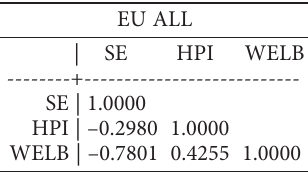
Table 3. Correlation Matrix (between SE, HPI and WELB) EU ALL |